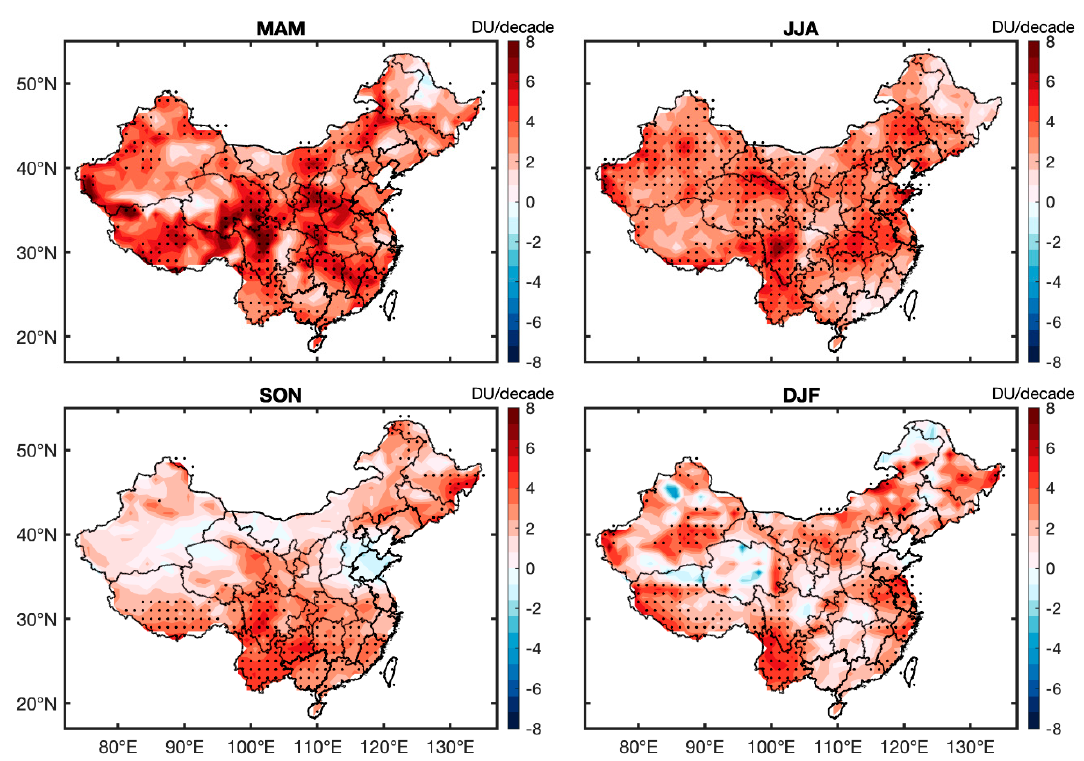
Figure 16. Seasonal OMI / MLS tropospheric ozone trends. The trends were calculated as the Sen’s slope and tested using the Mann–Kendall test. Trends with a significance level > 95% are marked with black dots.